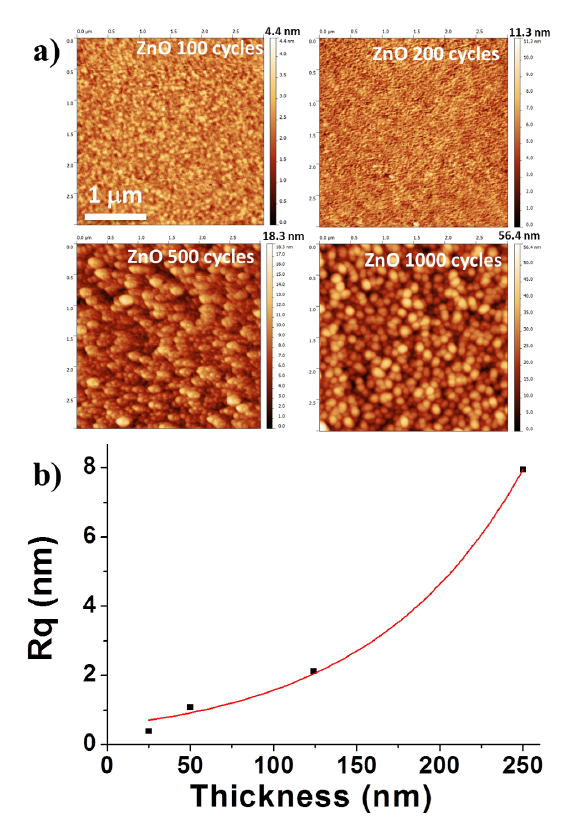
Figure 2: a) AFM images of the size of 3 × 3 μ m 2 of ZnO thin films deposited by 100, 200, 500 and 1000 cycles. b) Roughness as a func- tion of the film thickness.